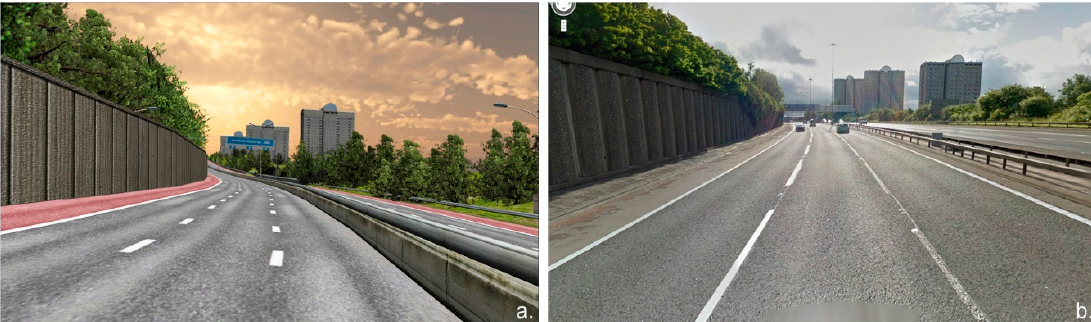
Figure 11. Motorway M8 section from Glasgow towards Edinburgh ( a ) VR digital twin city model screenshot as can be seen when driving in the VR driving simulator, ( b ) Google maps’ screenshot of the same spot in real-life.